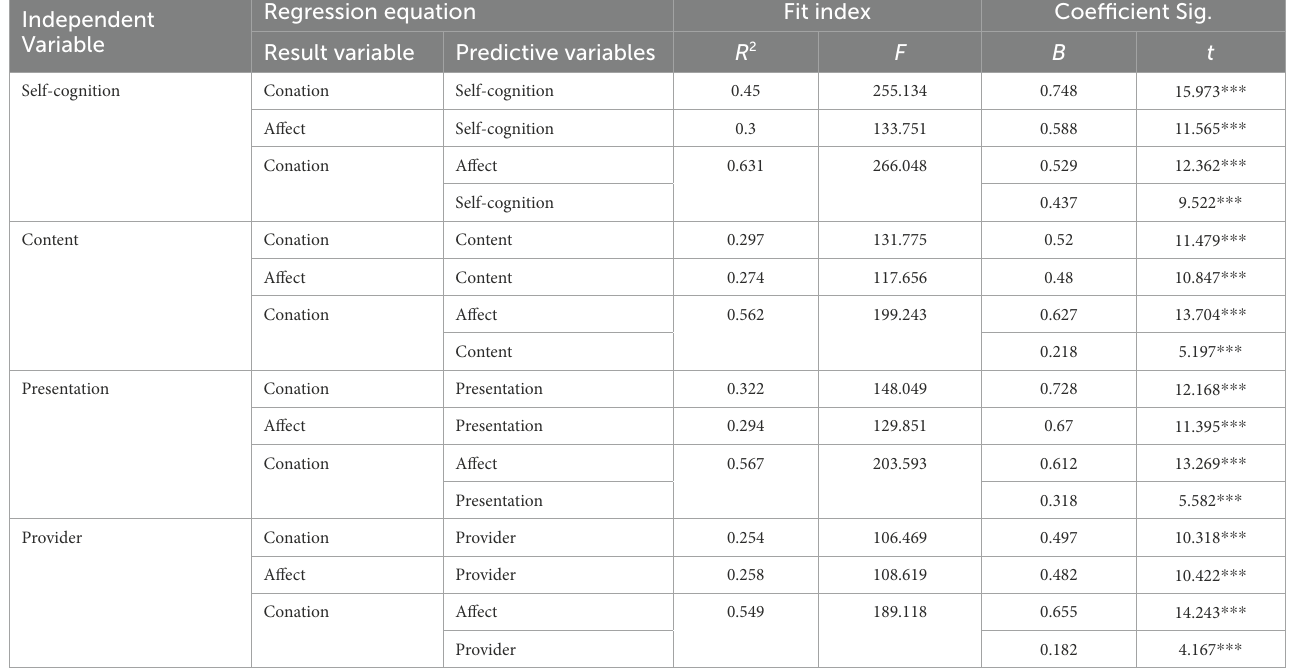
TABLE 9 Mediating model test of